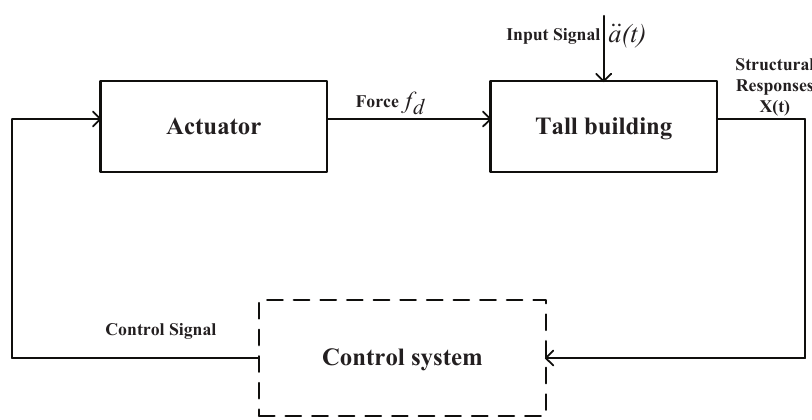
Figure 1. Schematic diagram of a vibration control system of a building structure.